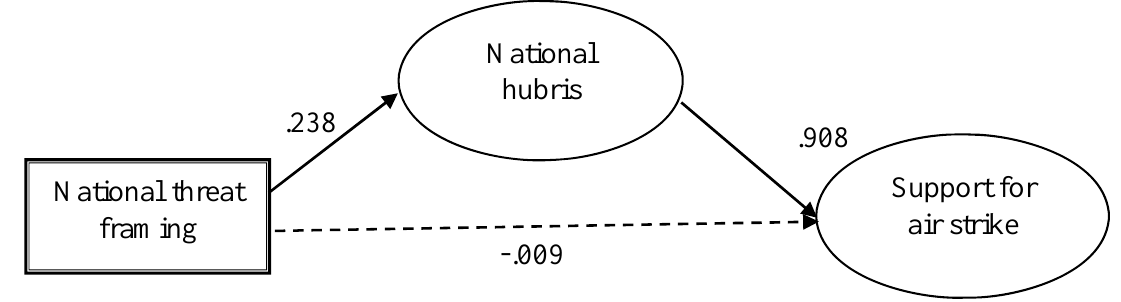
Figure 3: Effect of national threat framing on support for an air strike mediated by national